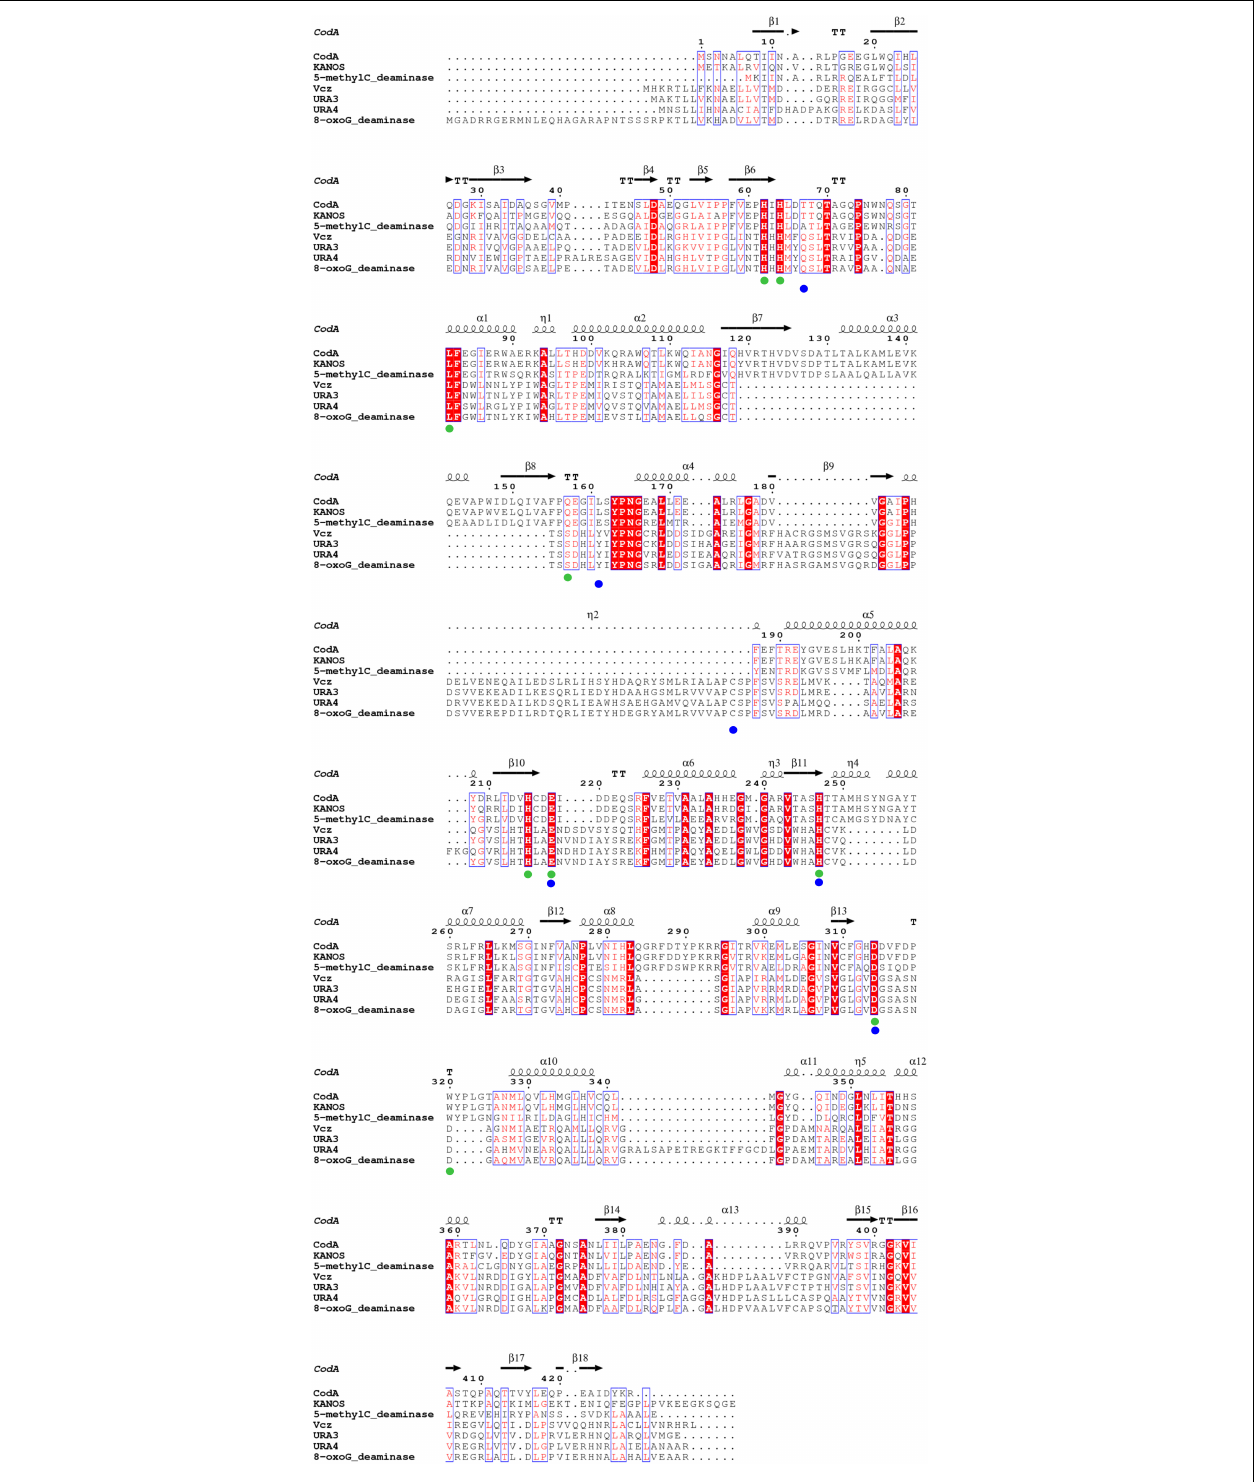
FIGURE 4 | Multiple amino acid sequence alignment of deaminases from the metagenomic libraries (KANOS, Vcz, URA3, and URA4) and those with confirmed functions and tertiary structures. CodA: E. coli cytosine deaminase, amino acid residues forming its active site are indicated in green circles (Ireton et al., 2002); 5-methylC_deaminase: Klebsiella pneumoniae 5-methylcytosine deaminase (Hitchcock et al., 2014); 8-oxoG_deaminase: 8-oxoguanine deaminase, amino acid residues forming its active site are indicated in blue circles (Hall et al., 2010). Highly similar residues are in red and framed in blue, strictly identical residues are in white on a red background. The alignment was performed using Clustal Omega (Sievers et al., 2011) and ESPript (Robert and Gouet, 2014).